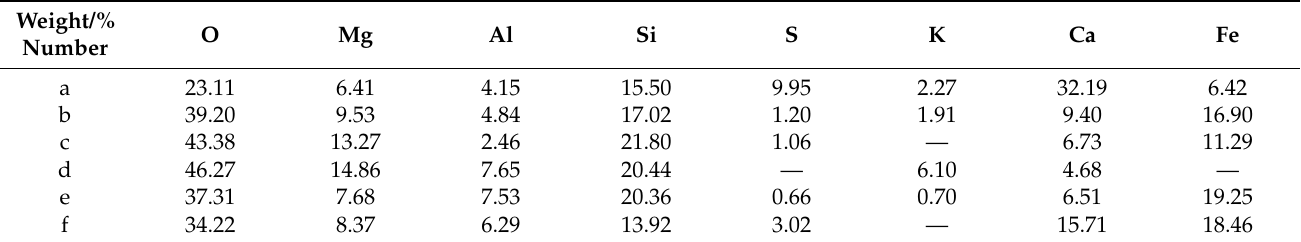
Table 3. EDS results of sample 7 on day 28 and day